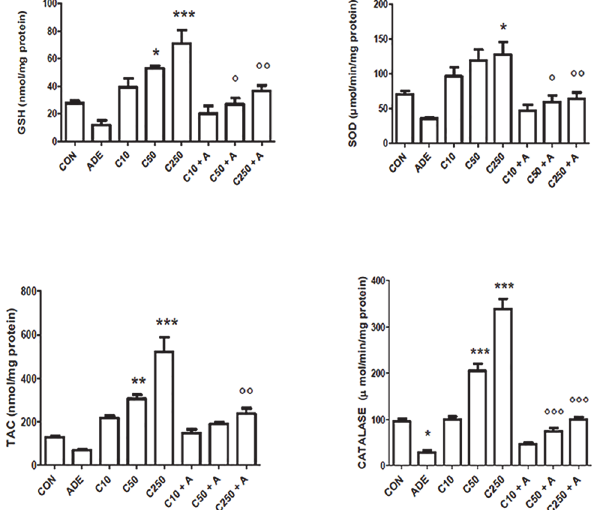
Fig 3. Effect of chrysin treatment on either renal concentration or activity of reduced glutathione (GSH), superoxide dismutase (SOD), total antioxidant capacity (TAC) and catalase (CAT) in control rats and rats treated either singly or concomitantly with either adenine (ADE) or chrysin (C) at doses of 10, 50 or 250 mg/kg. Each column and vertical bar is a mean ± SEM (n = 6).